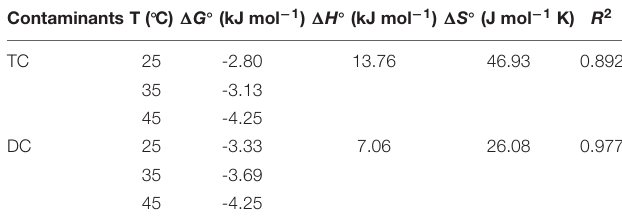
TABLE 3 | Thermodynamic parameters for TC and DC adsorption by BC/MnO 2